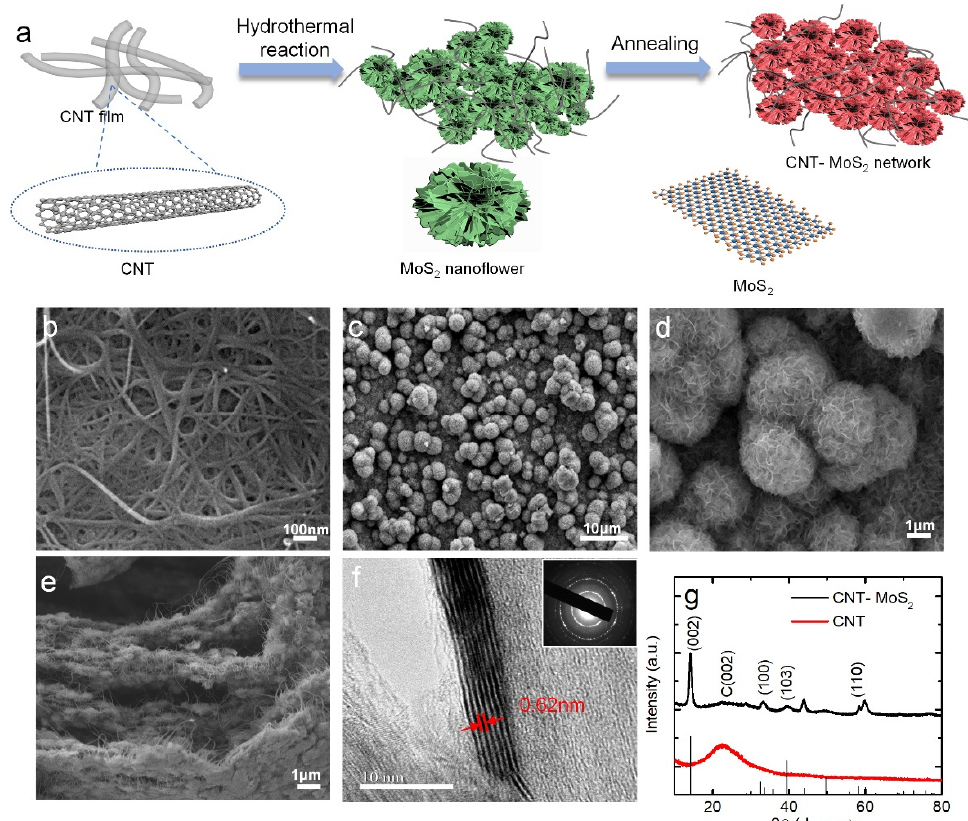
Figure 1. ( a ) Schematic illustration of the synthesis process of the CNT–MoS 2 composite network. ( b ) The SEM images of the unannealed CNT network. ( c , d ) The SEM images of the CNT–MoS 2 composite network with low to high magnification. ( e ) The SEM of the cross ‐ section of the CNT–MoS 2 composite network. ( f ) HRTEM images of the CNT–MoS 2 composite network. The inset shows the SAED pattern. ( g ) XRD spectrum of the unannealed CNT network and CNT–MoS 2 composite network.